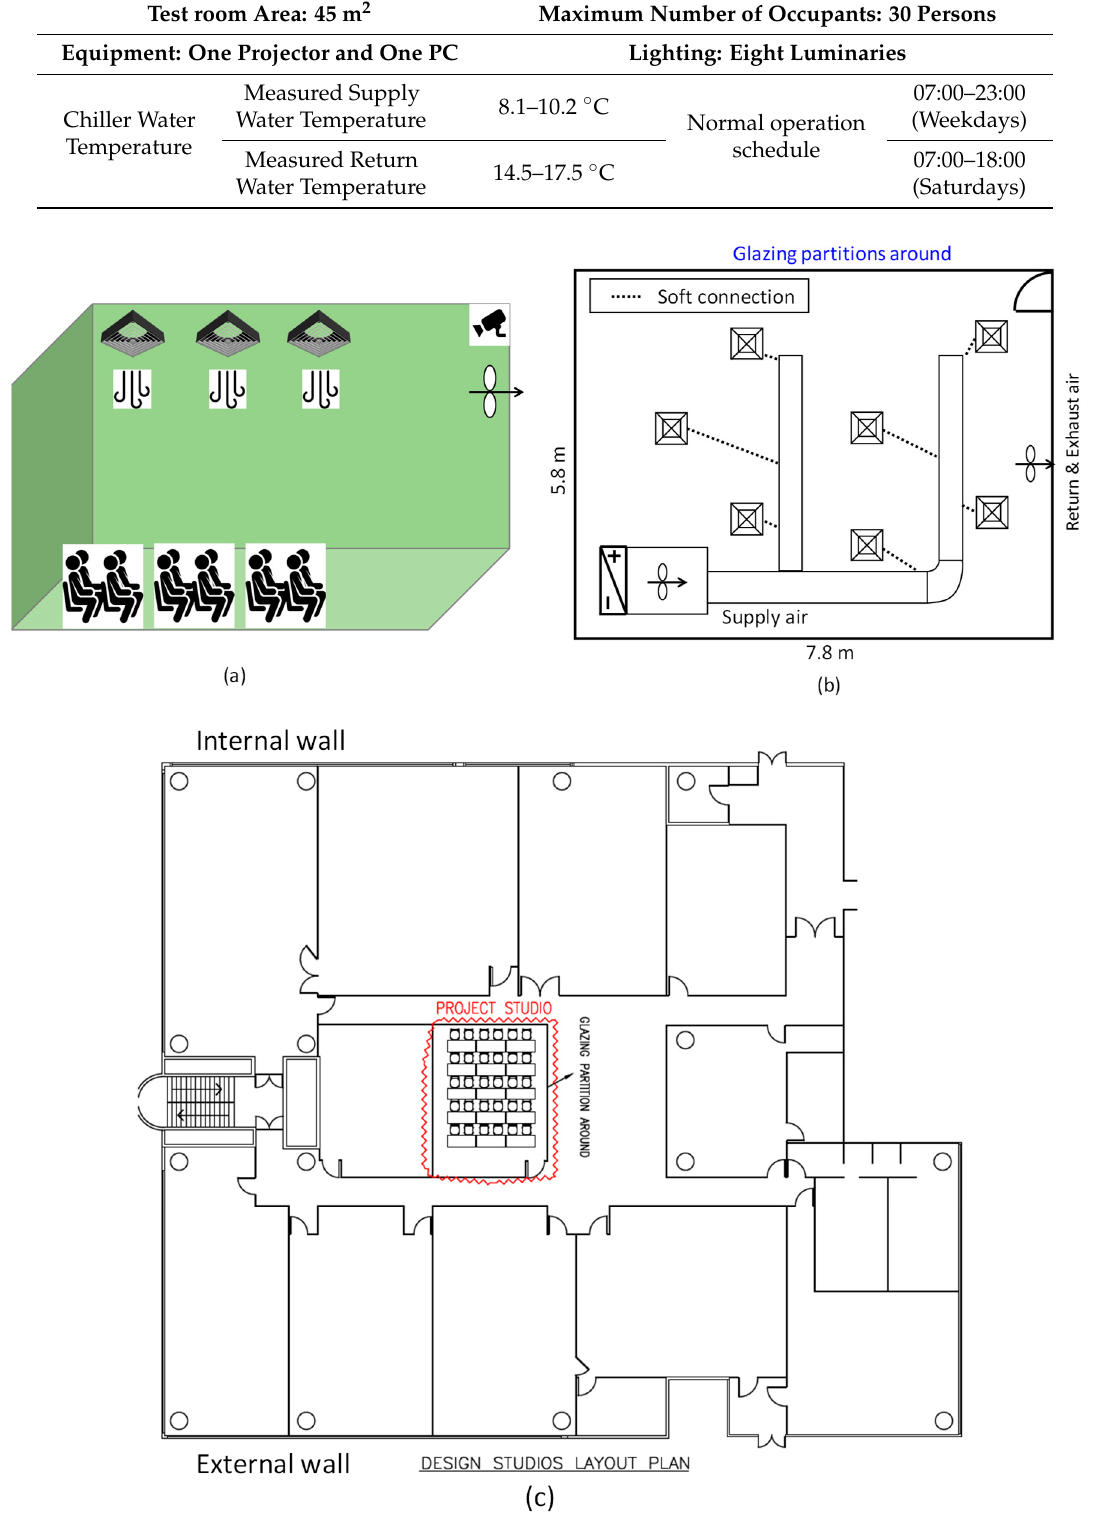
Figure 3. Test room: ( a ) 3D visualization; ( b ) cooling system schematic; ( c ) design studios layout plan.